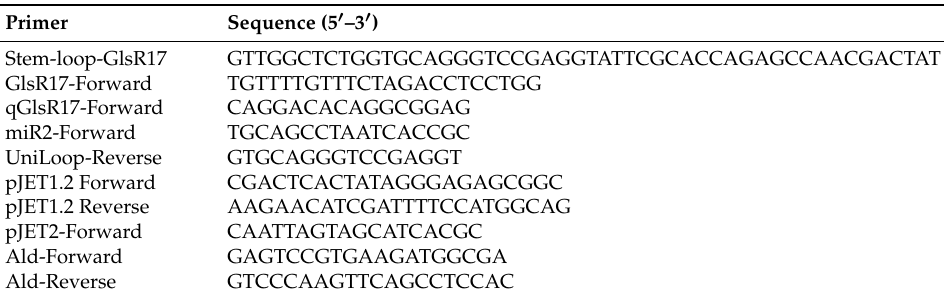
Table 1. Primers used in this